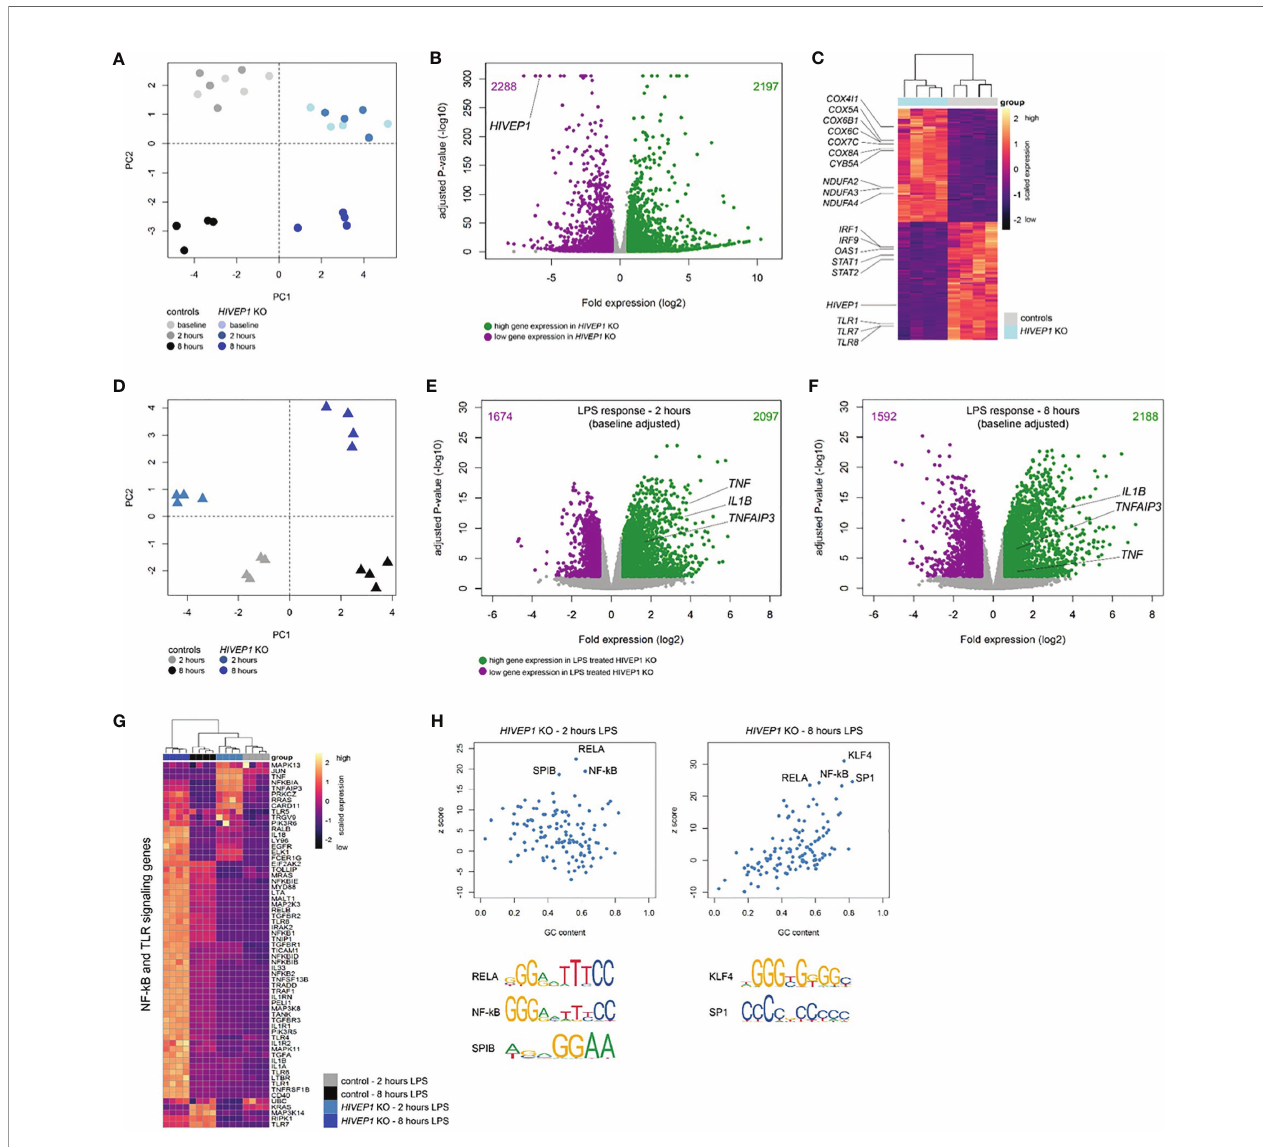
FIGURE 5 | RNA-sequencing of HIVEP1 de fi cient THP-1 cells before and after LPS stimulation. (A) Principal component plot of 30,013 genes per sample showing clustering of HIVEP1 de fi cient cells and controls at baseline and after 2 and 8 hours culturing in medium. (B) Volcano plot depicting genome-wide changes in gene expression of HIVEP1 de fi cient cells relative to controls at baseline. Green dots denote high expression genes (Benjamini-Hochberg (BH) adjusted p < 0.01 and fold change ≥ 1.5); purple dots depict low expression genes (BH adjusted p < 0.01 and fold change ≤ -1.5). (C) Unsupervised heatmap plot of 4485 signi fi cantly altered genes at baseline illustrating genes involved in oxidative phosphorylation, interferon signaling and pattern recognition receptors. (D) Principal component plot (30,013 genes) of LPS-treated (2 and 8 hours) HIVEP1 de fi cient cells and controls showing clear clustering. (E) Volcano plot depicting genome-wide changes in LPS-induced gene expression (corrected for baseline differences) of HIVEP1 de fi cient cells relative to controls at 2 hours. (F) Volcano plot illustrating transcriptomic differences in LPS-induced gene expression (baseline corrected) of HIVEP1 de fi cient cells relative to controls at 8 hours. (G) Heatmap representation of genes involved in Toll-like receptor and NF-kB signaling in LPS-treated samples. (H) Dot plots depicting z-scores against GC content of transcription factor binding site enrichment